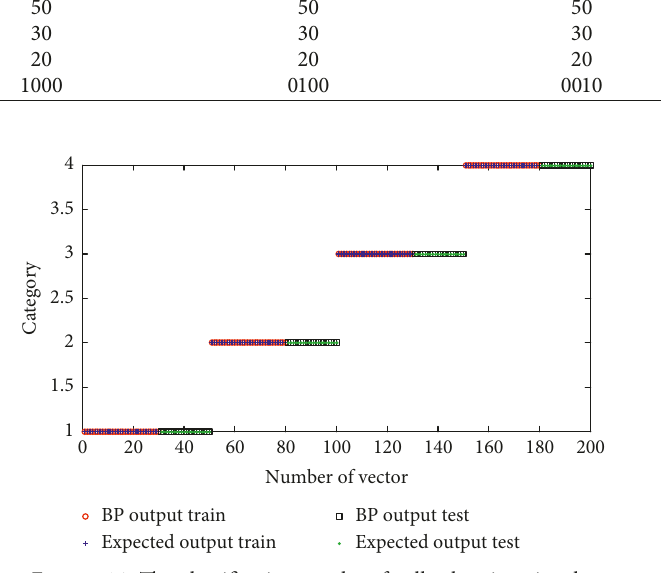
Figure 14: The classification results of roller bearing Table 5: Rolling element bearing parameters of 6205-2RS.